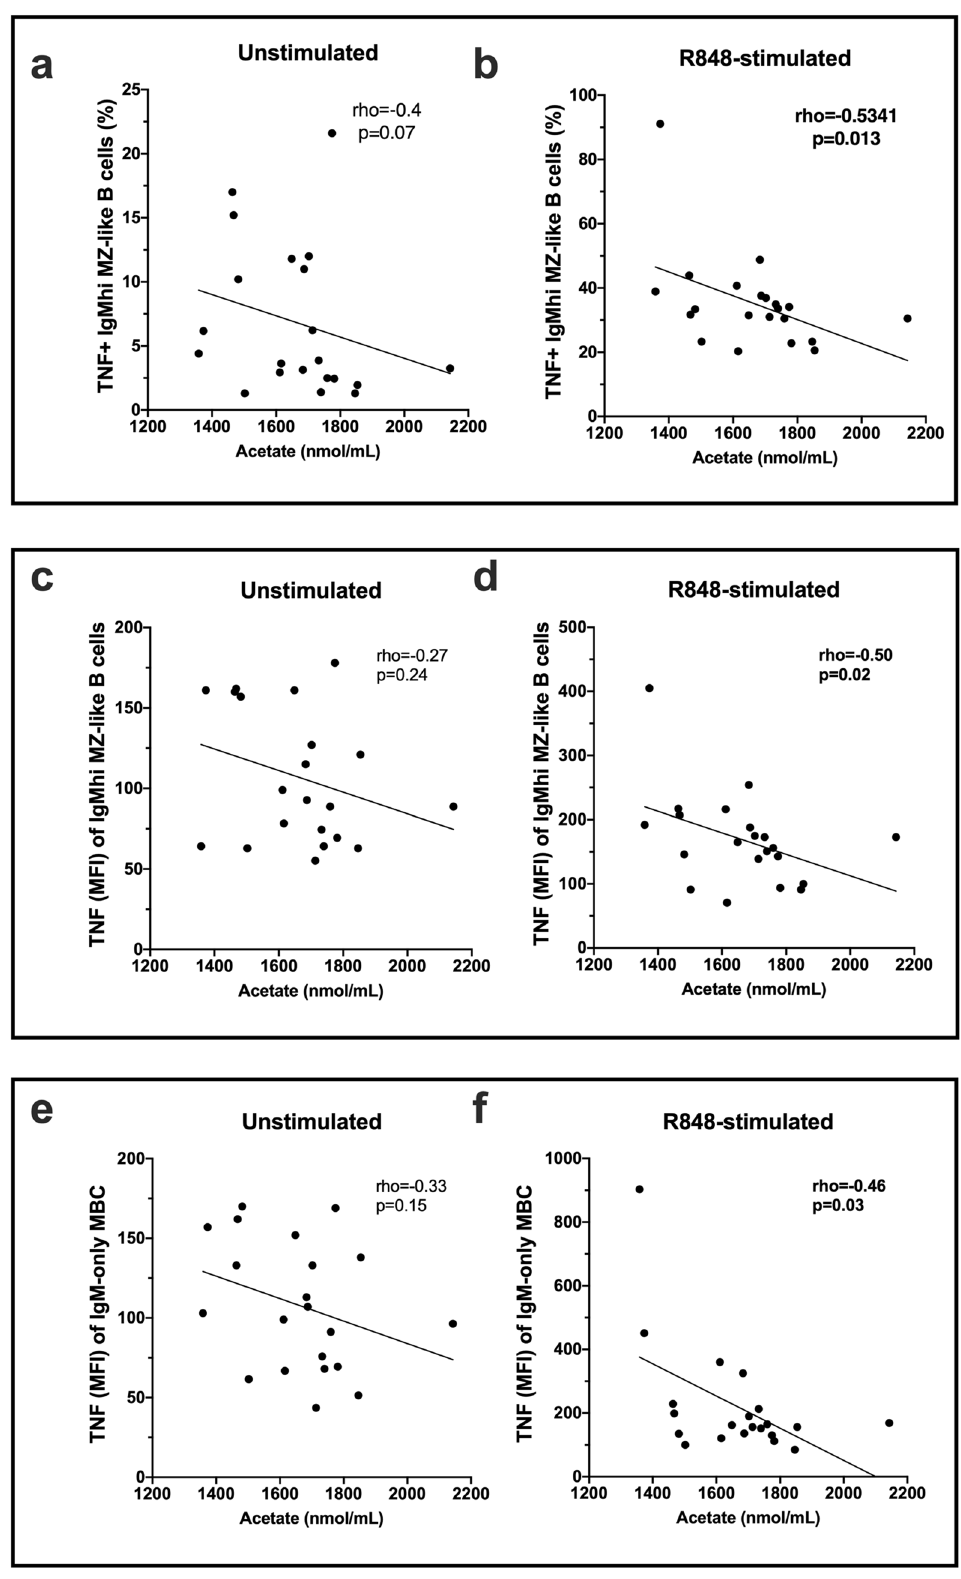
Figure 5. Correlations between serum acetate levels and TNF-producing B cells after PBMC culture for 18 h (n = 21). Cells were cultured with or without Resiquimod (R848) as indicated. (a,b) The proportion of unstimulated or R848-stimulated IgM hi MZ-like B cells expressing TNF (%) and (c,d) the expression (MFI) of TNF in unstimulated or R848-stimulated IgM hi MZ-like B cells. (e,f) The expression of TNF (MFI) in IgM-only memory B cells in unstimulated or R848-stimulated cells. Correlation was measured using nonparametric Spearman’s rho; statistically significant values are shown in bolded font. Line of regression is shown for illustrative purposes